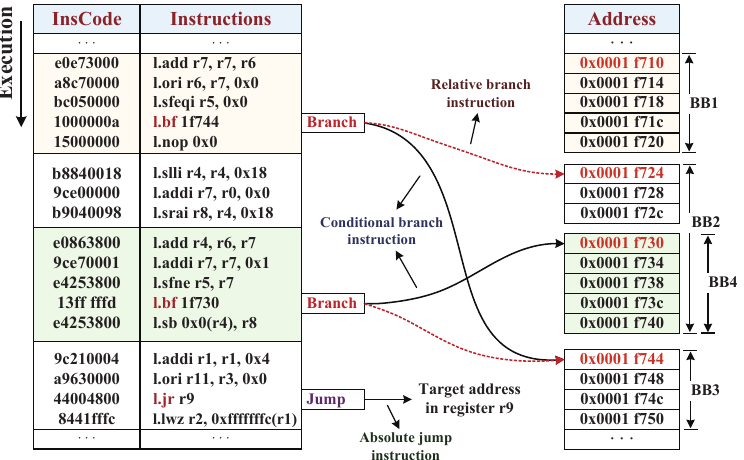
Figure 3. An example of the benchmark OpenECC instruction segmentation for illustrating the proposed partition strategy of